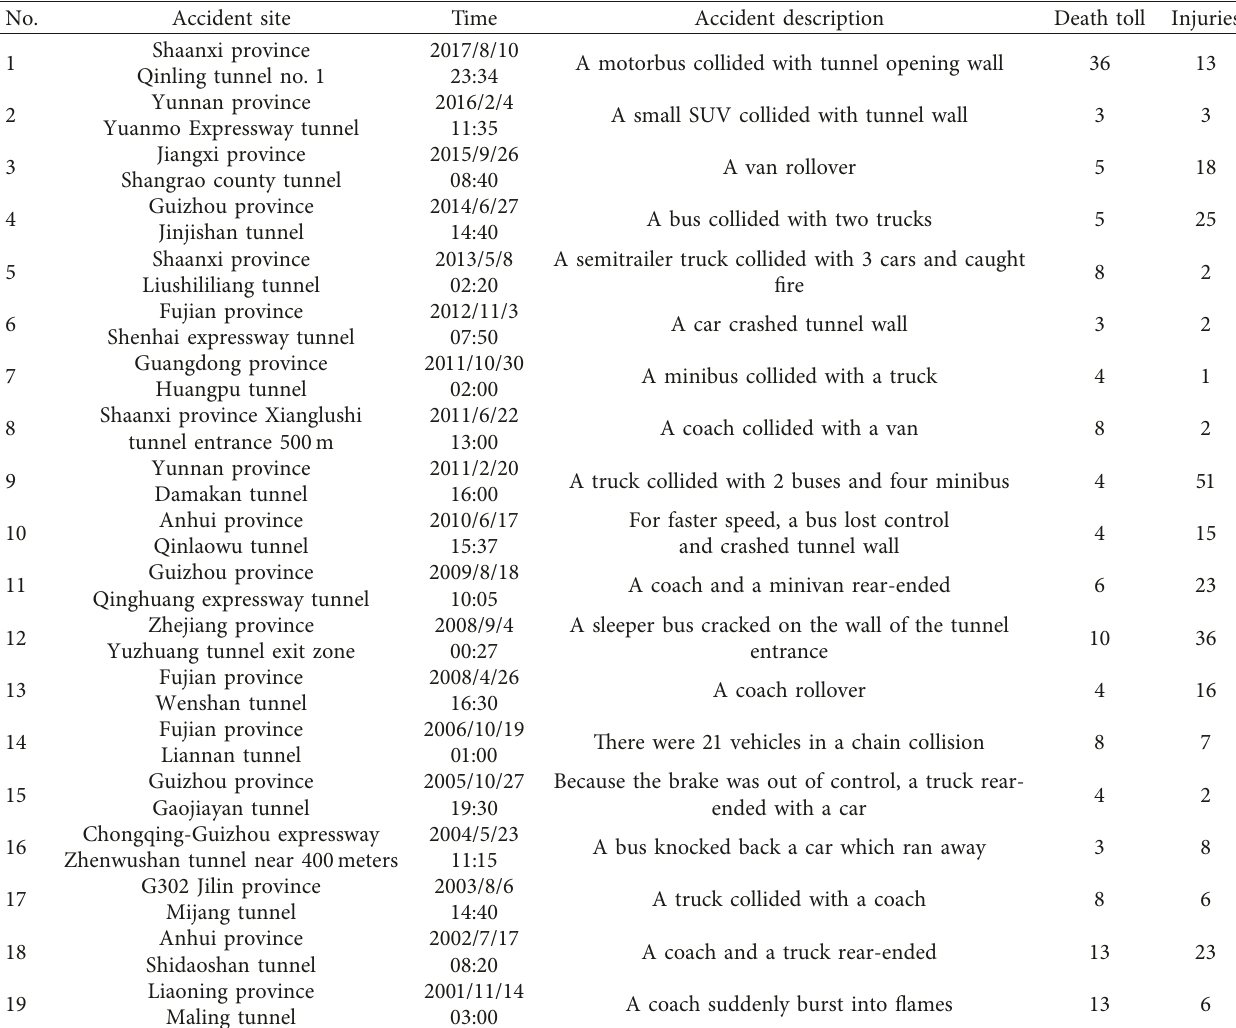
Figure 1: (a) Number and length of expressway tunnels and (b) tunnel traffic accident locations. Table 1: Part of the fatal and serious traffic accidents in China expressway